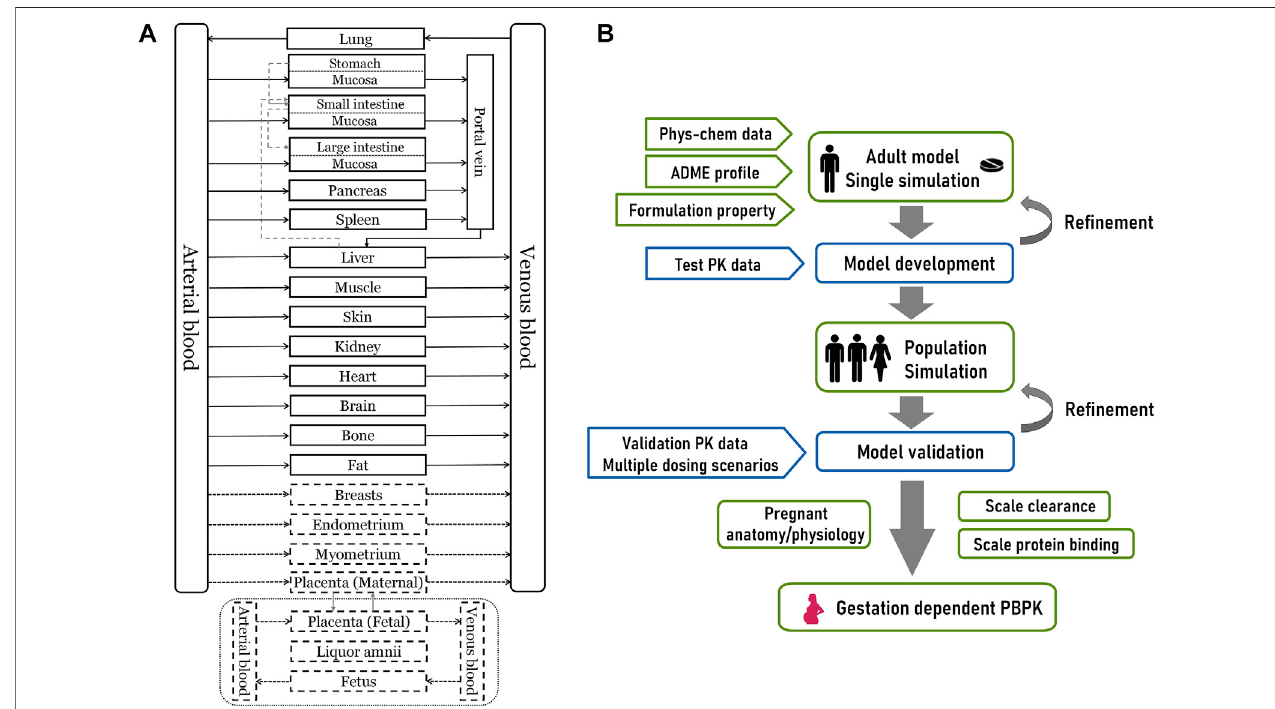
FIGURE1| Theoveralldesignofthismodelingstudy (A) A27-compartmentphysiologicalmodelofpregnantwomeninMobi ® .Thedottedportionisninegestation- speci fi c compartments (B) The schematic diagram for PBPK modeling work fl ow. Phys-chem, physicochemical; ADME, absorption, distribution, metabolism, and excretion.